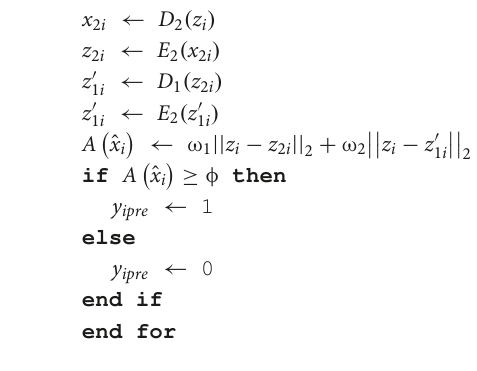
Algorithm 2. Model testing